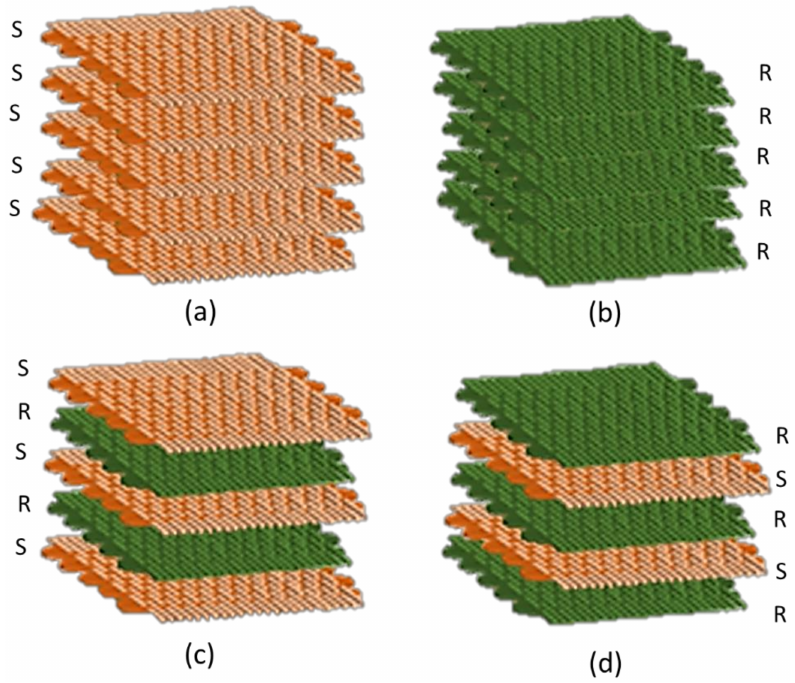
Figure 12. Various hybrid composite stacking sequences: ( a ) SSSSS, ( b ) RRRRR, ( c ) SRSRS, and ( d ) RSRSR [45]. Extracted from Ref. [45] with